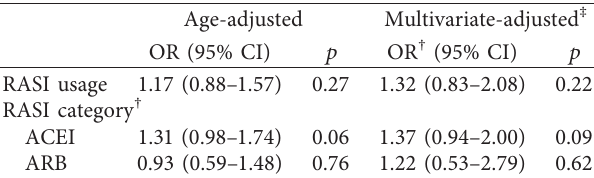
Table 2: Age- and multivariate-adjusted ORs for any AMD among the study population.